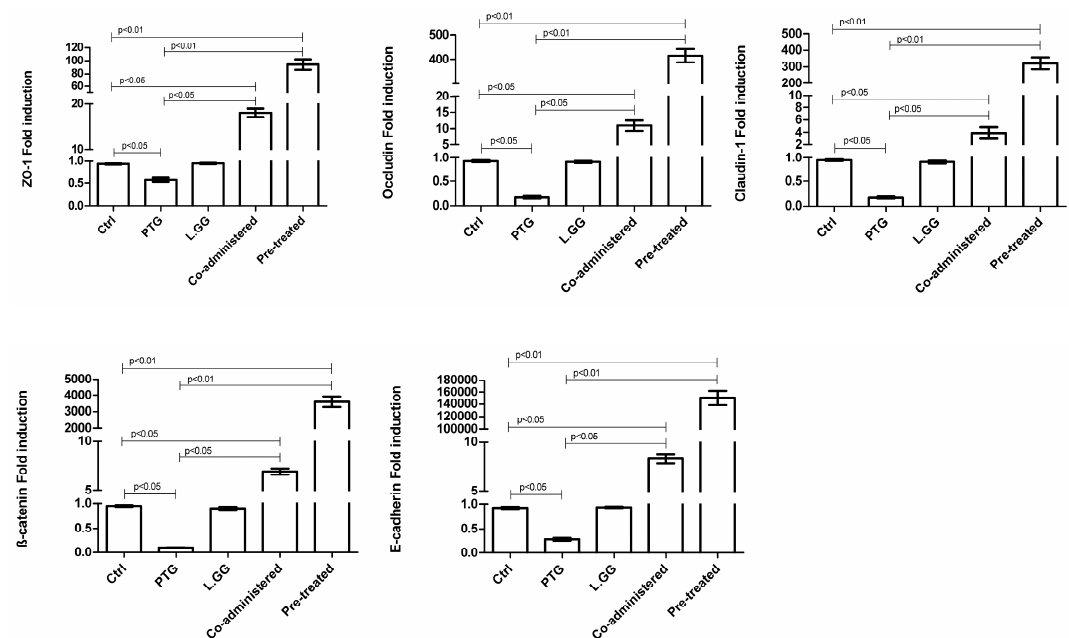
Figure 4. Transcription analysis of ZO-1, Occludin, Claudin-1, β -catenin and E-cadherin genes by qPCR in jejunal tissue samples from control and treated rats. Ctrl (without treatment); PTG (sensitized with 1000 U IFN- γ and treated with PTG 50 µ g/day for ten days); L.GG (treated with L.GG 1 × 10 9 CFU for ten days); Co-administered (sensitized with 1000 U IFN- γ and co-administered with PTG and L.GG for ten days); Pre-treated (sensitized with 1000 U IFN- γ , pre-treated with PTG for ten days, and then administered with L.GG for further ten days). All data represent the results of three different experiments (mean ± SEM). Data were expressed as Fold induction. Data were analysed by Kruskal-Wallis analysis of variance and Dunn’s Multiple Comparison Test.